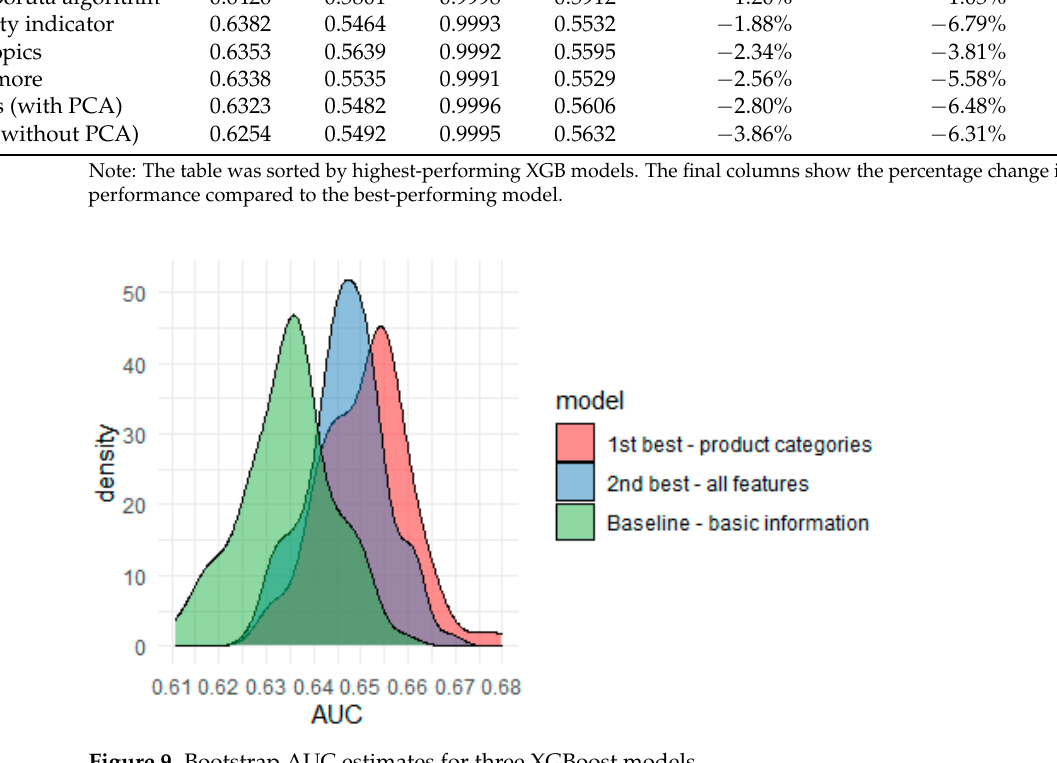
Figure 9. Bootstrap AUC estimates for three XGBoost models.